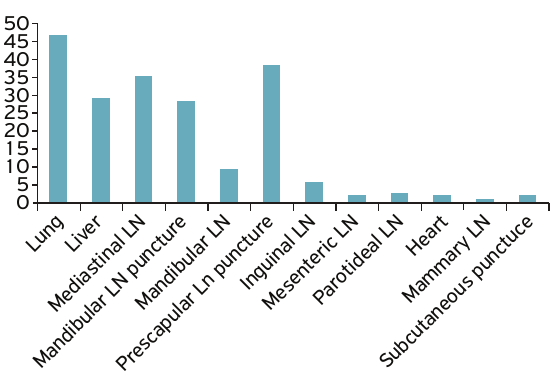
Figure 1. Distribution of sheep tissue samples analyzed in this study. Samples were collected from animals in a slaughterhouse and from naturally infected